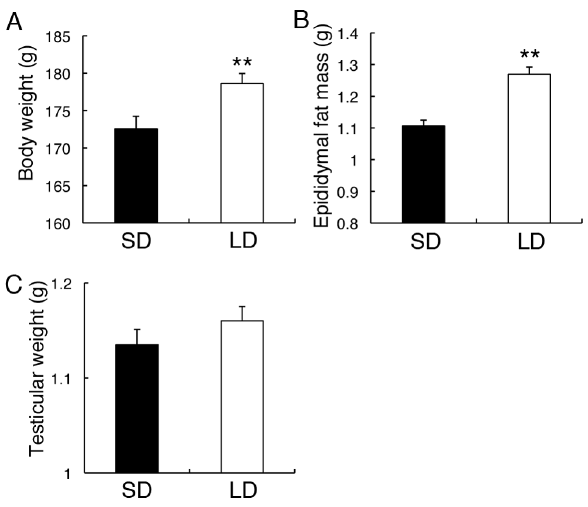
Figure 1. Effects of photoperiod on body weight, epididymal fat mass, and testicular weight in Fischer 344 rats. Rats were maintained under either short-day condition (SD, 8 h of light, 16 h of darkness, black bars ) or long-day condition (LD, 16 h of light, 8 h of darkness, white bars ) for 2 weeks. Body weight (A) and epididymal fat mass (B) of the rats maintained under LD were larger than those maintained under SD, whereas testicular weight (C) did not differ between rats maintained under SD and LD. Testicular weight and epididymal fat mass are indicated as the average of left and right specimens. **, P , 0.01, t -test. Values are means + SEM